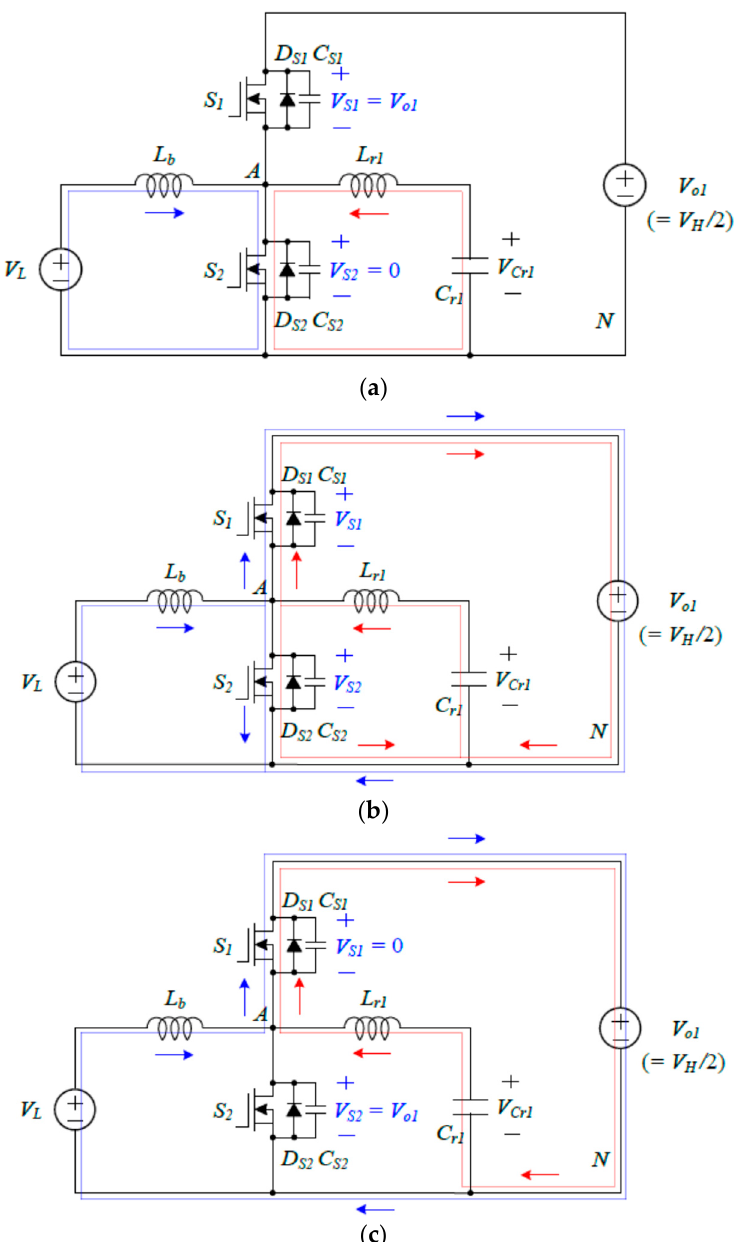
Figure 5. The equivalent circuit diagrams of the proposed converter for the turn-on switching transition for S 1 : ( a ) Stage I in the step-up mode; ( b ) switching transition from Stage I to Stage IV in the step-up mode; ( c ) Stage IV in the step-up mode.